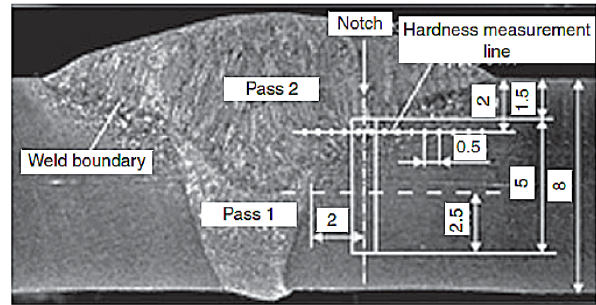
Figure 4: The configuration of V-joint with 2 passes welded joint. Reprinted with permission from Pirinen et al. // Welding Interna- tional. (2015). ©2015 Tailor &